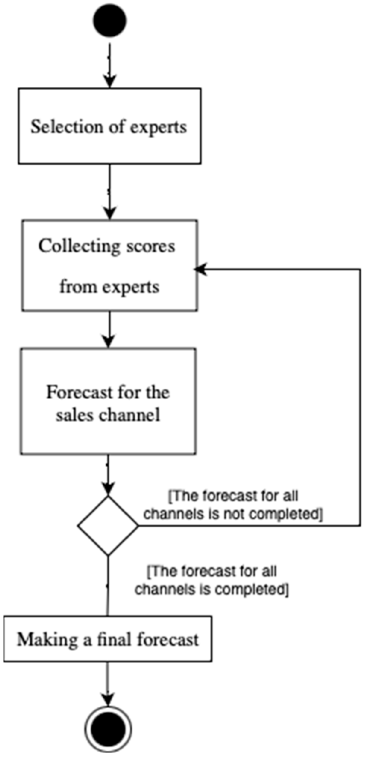
Figure 1. Algorithm of forecasting by the method “sales staff opinion”.